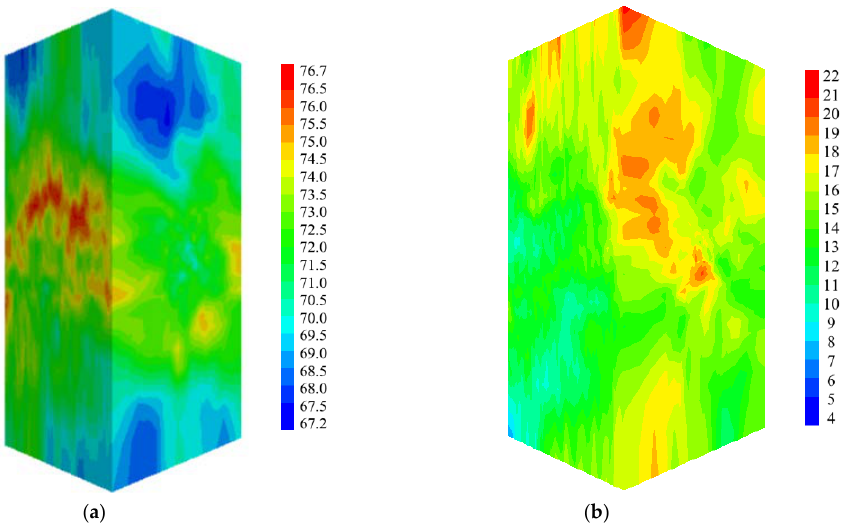
Figure 5. Three-dimensional (3D) maps of the RMR simulated on the target grid mesh, for: ( a ) realisation n. 1; and ( b ) variance of the 100 realisations. Table 2. RMR and UCS (in MPa) statistics for realisation number 1.